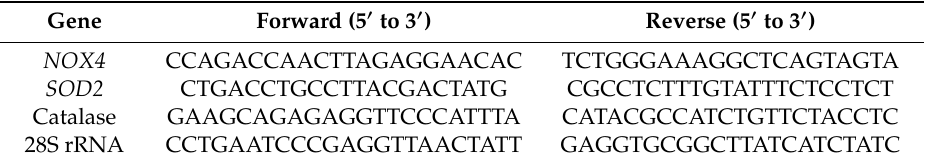
Table 1. Primer sequences used for real-time RT-PCR